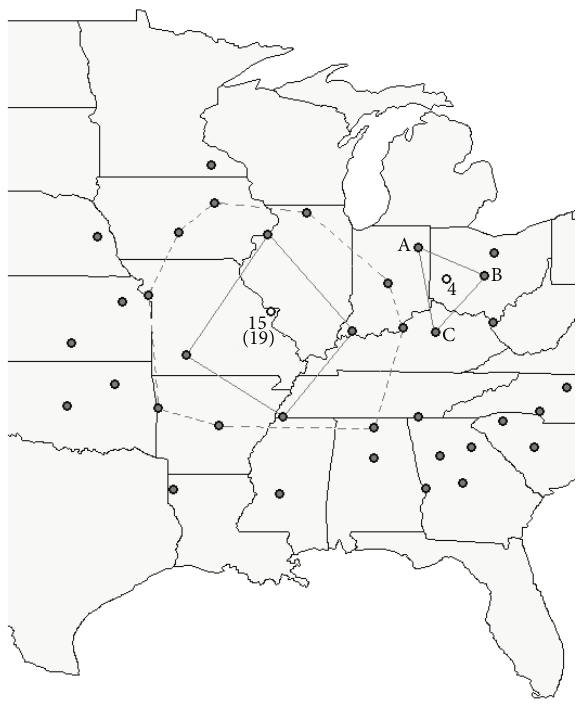
Figure 2: Location of the meteorological stations (4, 15, and 19 denote central points, and, A, B, and C denote border points) whose data used for testing the spatial interpolation method. Three example polygons are presented with central points 4, 15, and 19 (see Table1).Polygon#15andpolygon#19havethesamecentralpointbut have 4 (solid line) and 9 (dashed line) border points, respectively.